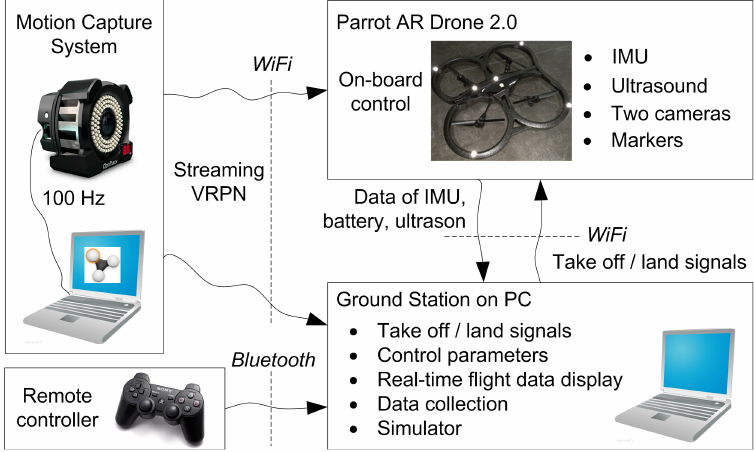
Figure 4. The experimental setup of the real-time